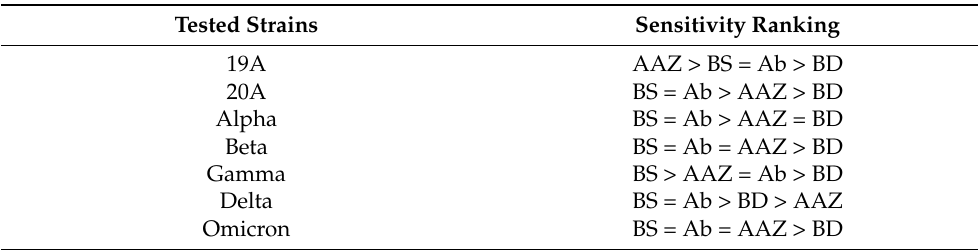
Table 2. Comparison of the analytical sensitivity of the four tested RFLTs regarding different SARS- CoV-2 lineages.